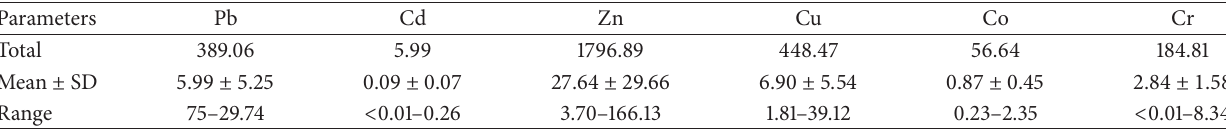
Table 2: Overall mean metal concentrations (mgkg −1 , dry weight) in tree bark